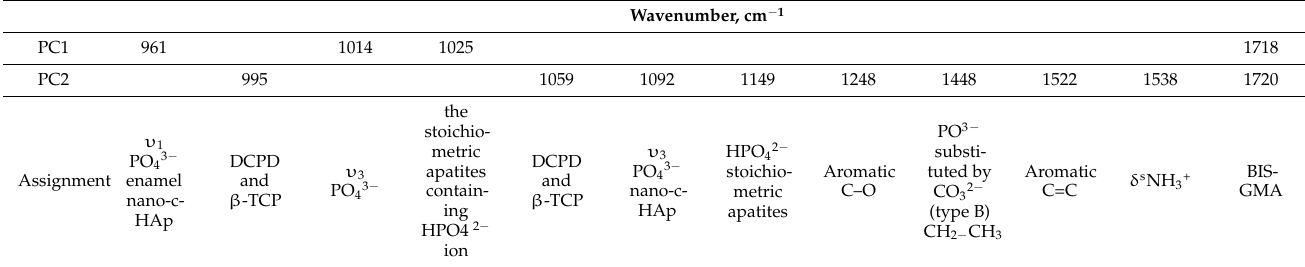
Table 3. Results of PC loading plots for PC1 and PC2: wave numbers of the most prominent peaks and troughs in the PCA loading plots and their correlation with functional groups based on a literature search (see Table